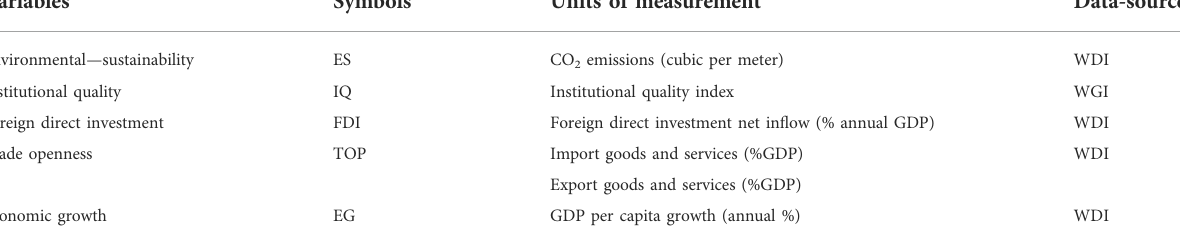
TABLE 1 Description of